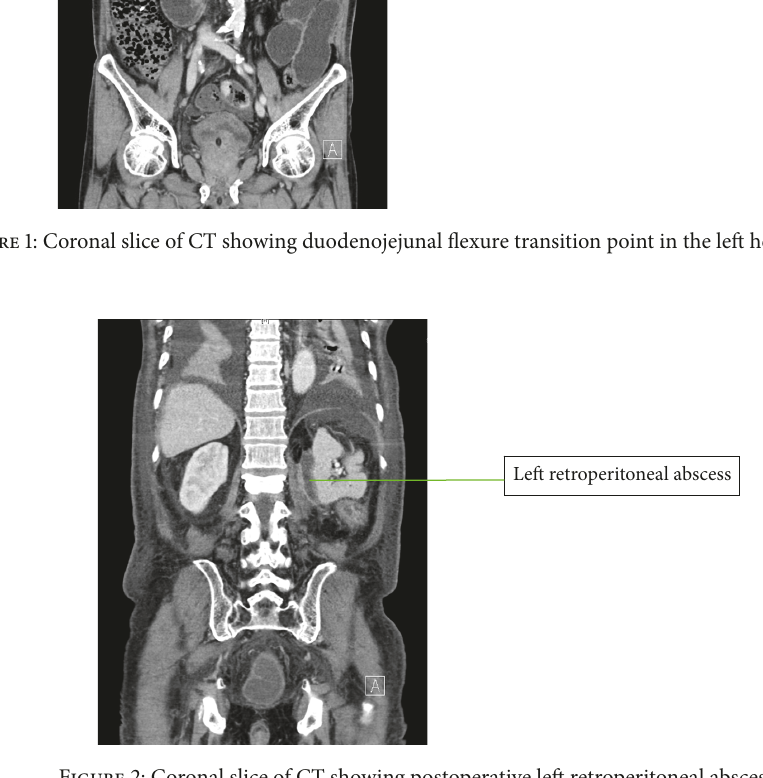
Figure 2: Coronal slice of CT showing postoperative left retroperitoneal